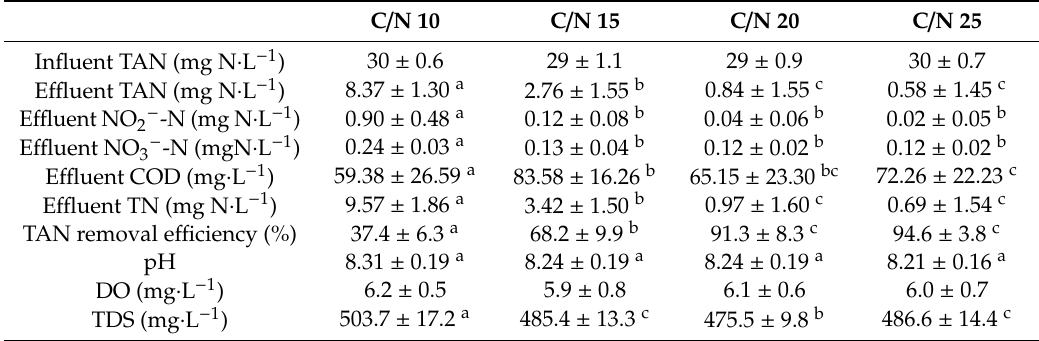
Table 1. Water quality parameters of the influent and e ffl uent of the reactors at di ff erent C / N ratios (mean ± standard